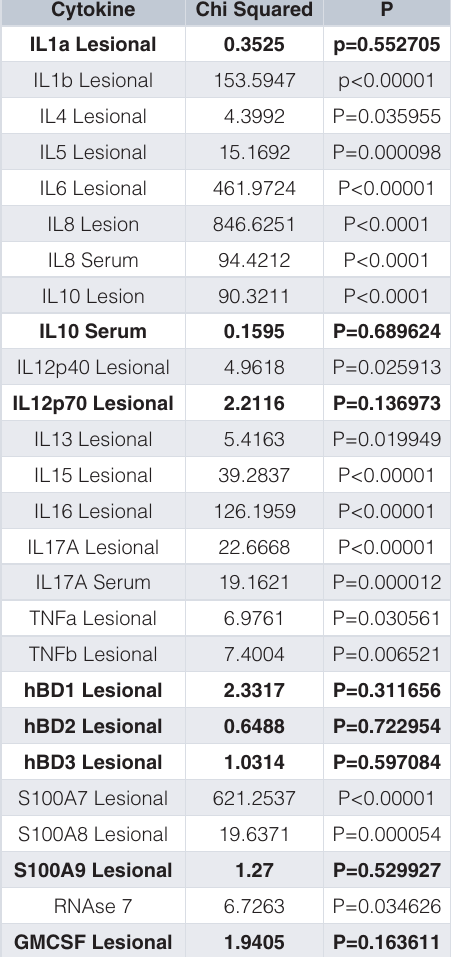
Table 7. Table of heterogeneity of cytokine studies by chi-squared tests for